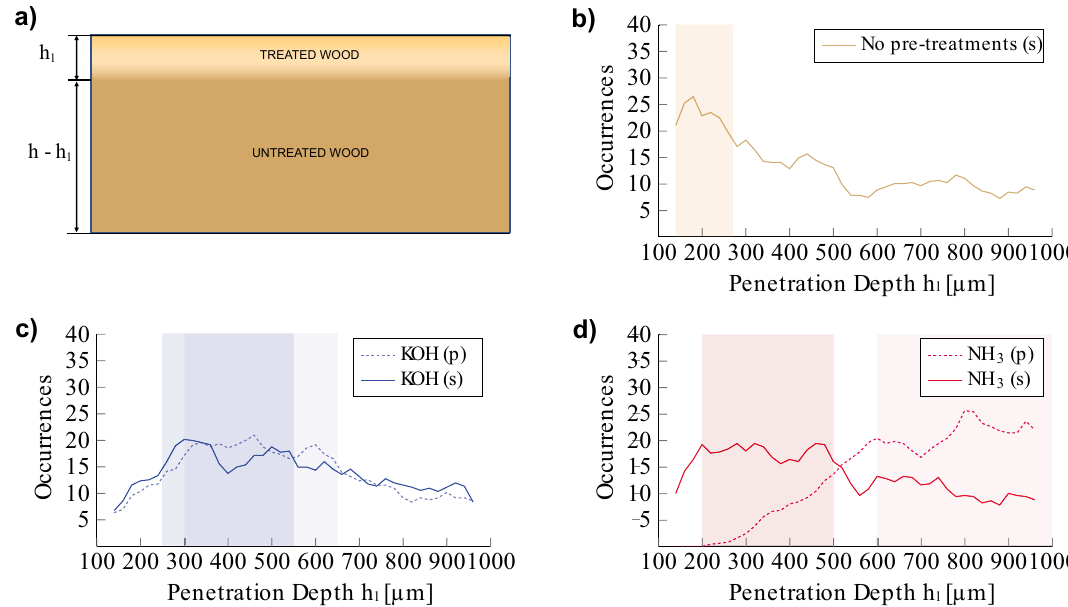
Figure 4. ( a ) Diagram of the transversal profile assumed in the FE model for the characterization of the treated side of the specimen. ( b ) Distribution of penetration depths h l making the FE model best approximate the modal frequencies of plates 1-3, only sized. ( c ) Distribution of penetration depths h l making the FE model best approximate the modal frequencies of plates 4-6, pre-treated with KOH. ( d ) Distribution of penetration depths h l making the FE model best approximate the modal frequencies in plates 7-9, pre-treated with NH 3 . Histograms are evaluated when plates are only pre-treated ( t = p , dashed lines) and after the application of the complete primers ( t = s , solid lines). Colored regions highlight the ranges of preferential values characterizing each combination of